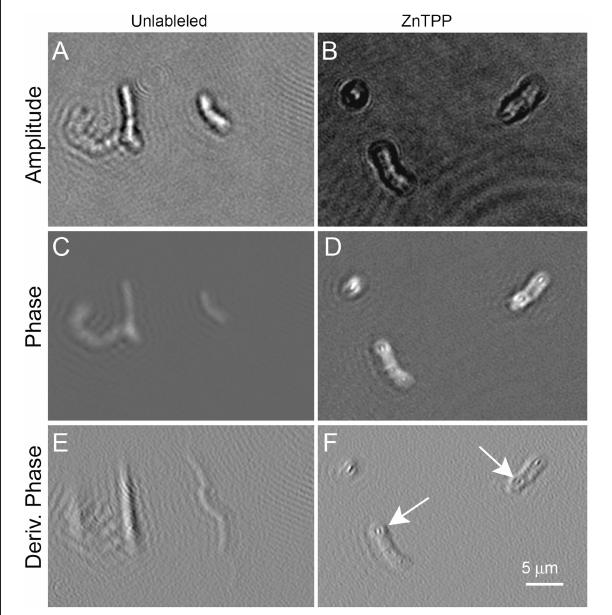
FIGURE 6 | Bacillus subtilis cells unlabeled (on the left) or incubated with ZnTPP (on the right). Scale bar applies to all panels. Phase range is –pi to pi. (A,B) Amplitude images. (C,D) Phase images. (E,F) First derivative of phase in x direction. The arrows indicate areas where intracellular features may be seen. The exact identity of the features is uncertain, but their position suggests